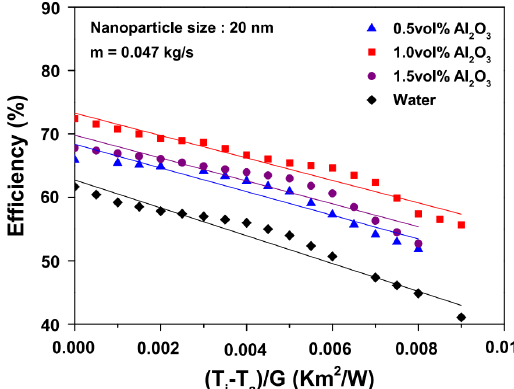
Figure 21. Reduction in the photothermal energy conversion efficiency of nanofluids according to the deviation from the optimal temperature [76]; 2020, Elsevier.